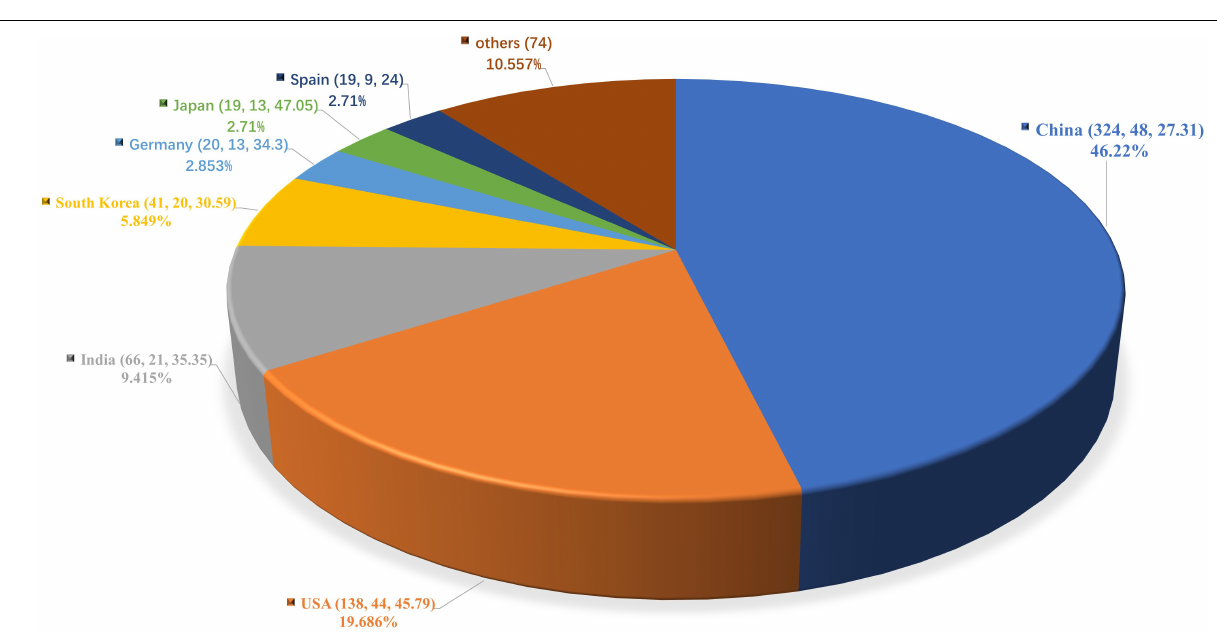
FIGURE 1 | The annual publication and citation growth of literature.